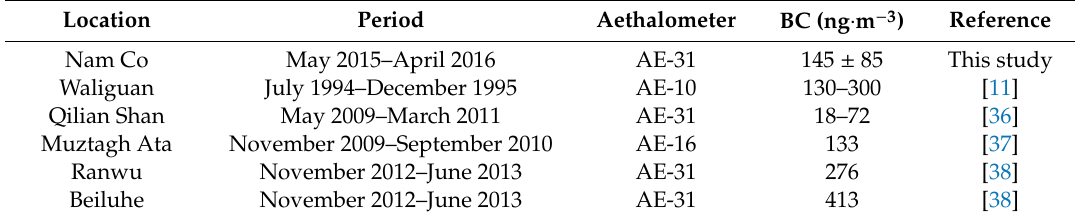
Table 1. BC concentration with aethalometer in some remote region over the Tibetan